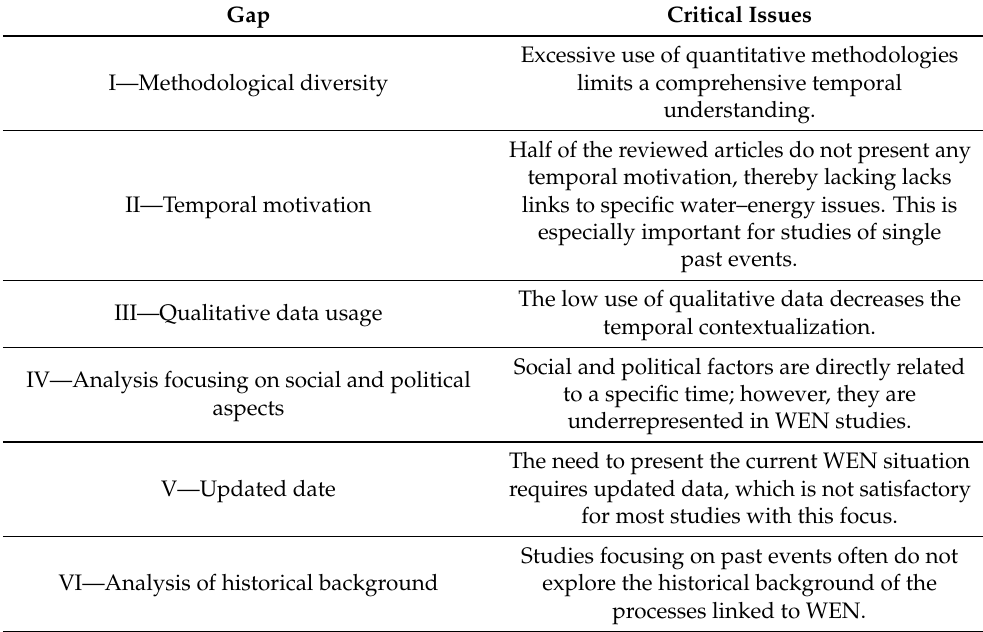
Table 3. Summary of main gaps in the temporal understanding of WEN